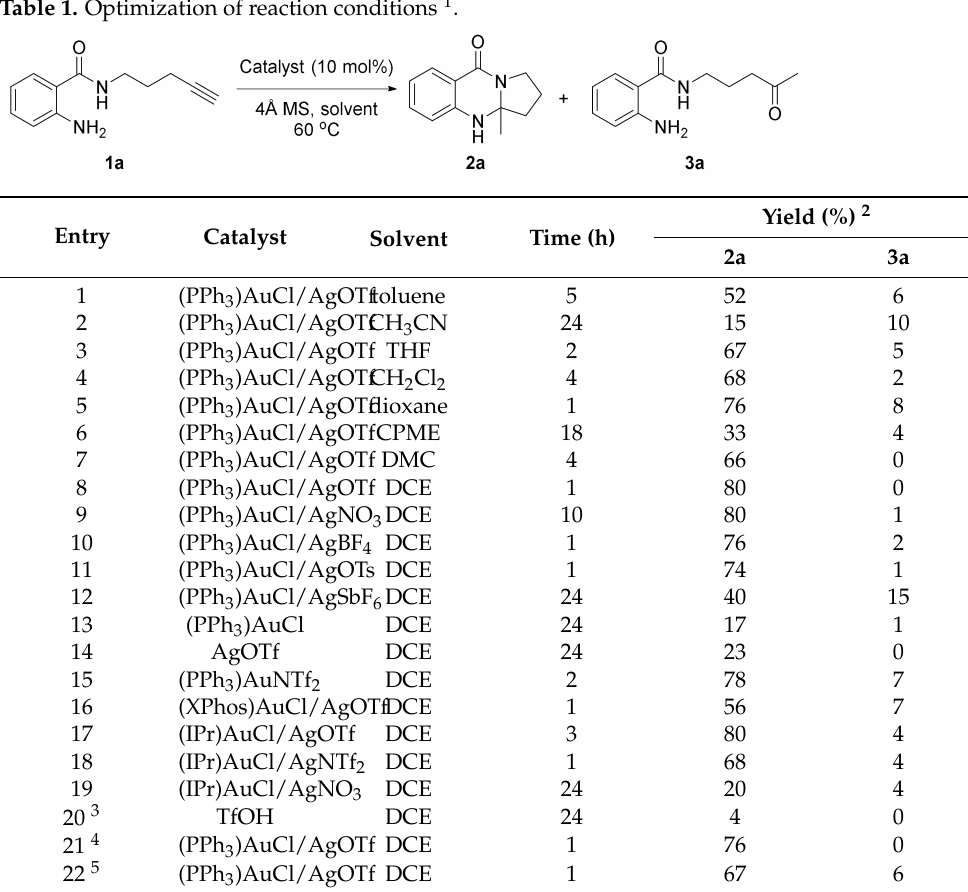
Table 1. Optimization of reaction conditions 1